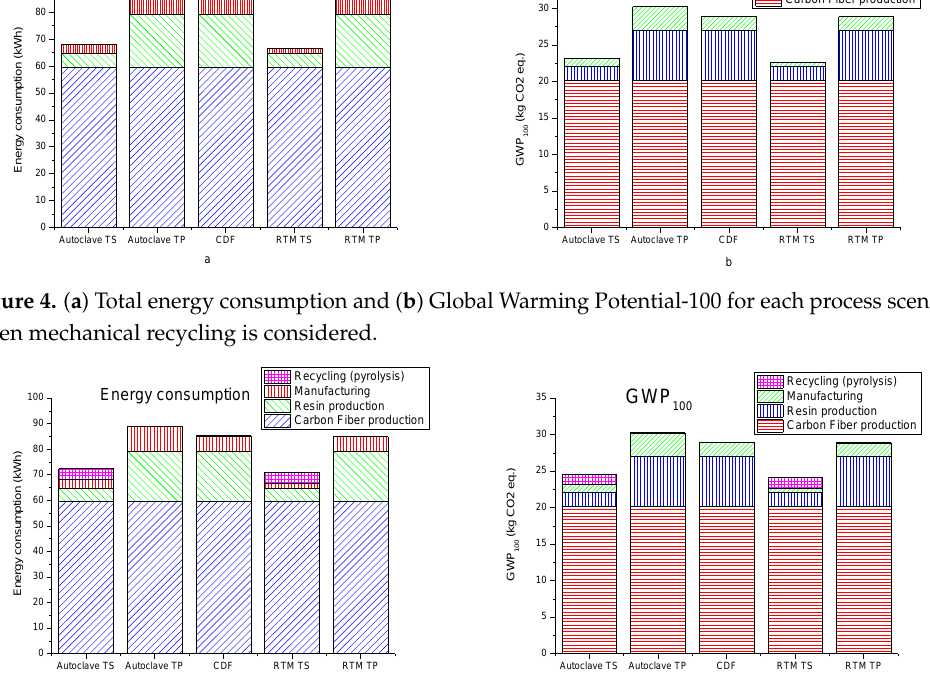
Figure 5. ( a ) Total energy consumption and ( b ) Global Warming Potential-100 for each process scenario when mechanical recycling is considered for thermoplastic and pyrolysis for thermosetting composite.